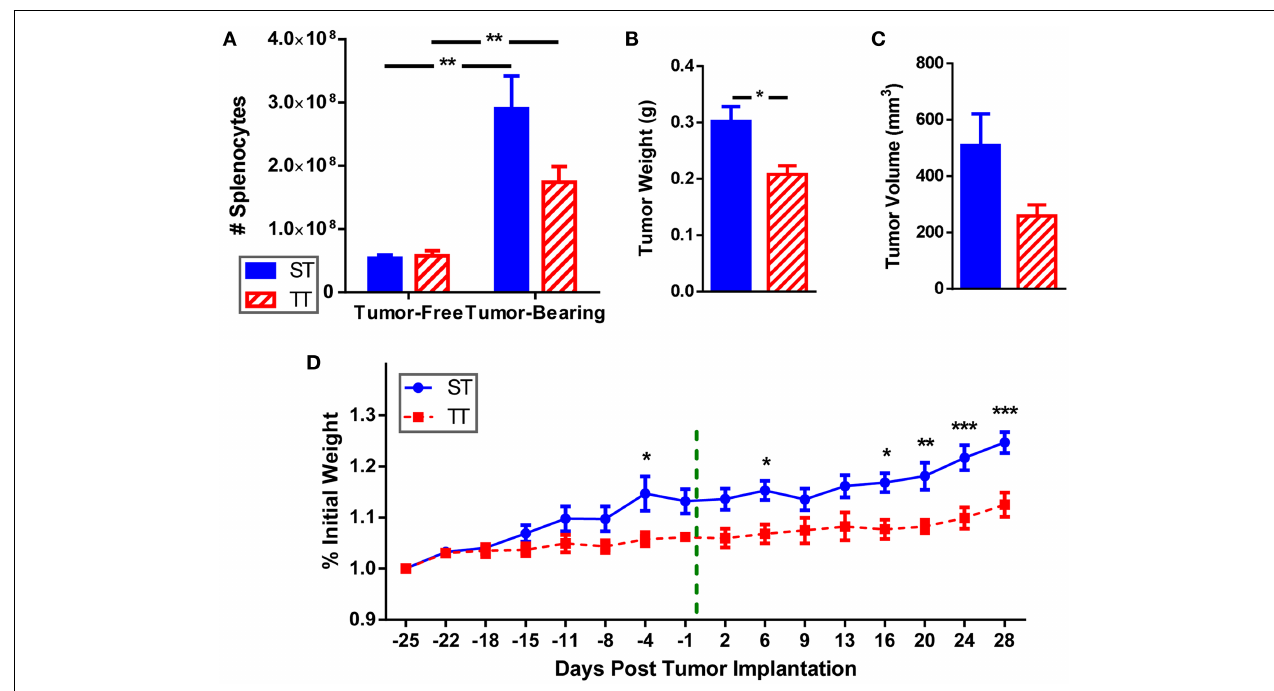
FIGURE 1 | Splenocytes, tumor size, and body weight are increased when mice are maintained at ST compared toTT . 4T1 tumor-bearing BALB/c mice and age-matched controls were maintained at ST orTT. (A) Splenocytes obtained from control and tumor-bearing mice were counted and (B) tumor weight and (C) volume were measured.